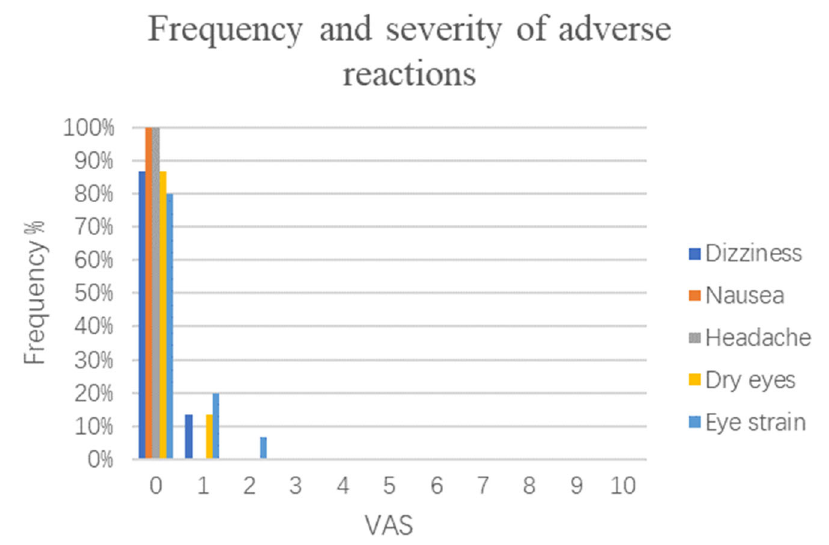
Figure 6. The bar diagram depicts the self-reported incidence and extent of adverse reactions associated with the IVR experience. The horizontal axis represents the percentage of adverse symptoms that occurred, including dizziness, nausea, headache, dry eyes, and eye strain. The vertical axis represents the severity of adverse symptoms experienced by individuals using a VAS, where 0 means no occurrence, and the higher the number, the more severe the adverse symptoms. Five colored lines are used to represent five adverse symptoms. VAS, visual analog scale.